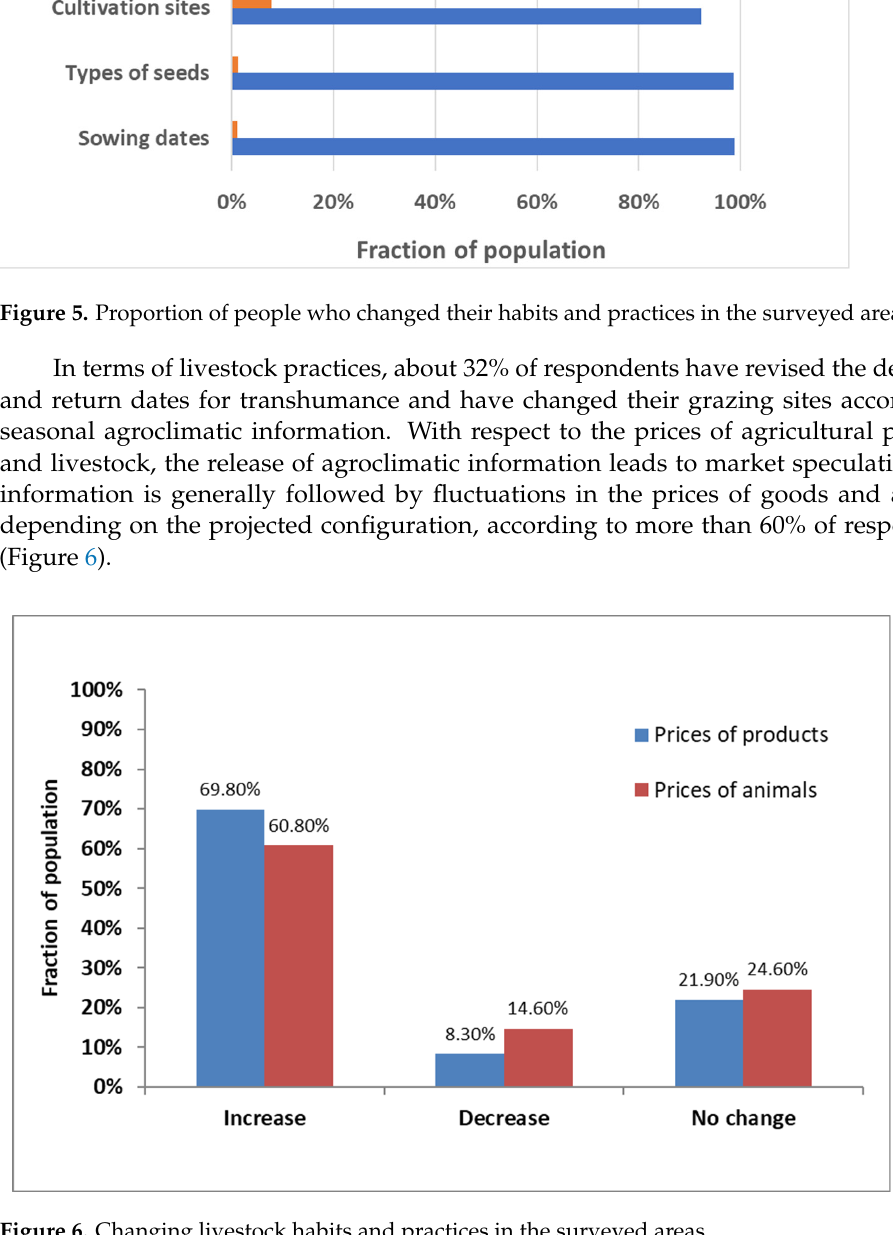
Figure 6. Changing livestock habits and practices in the surveyed areas.